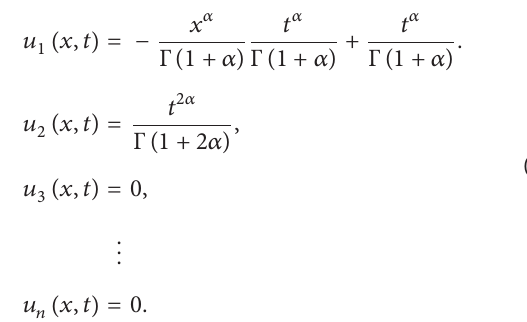
subject to the initial value